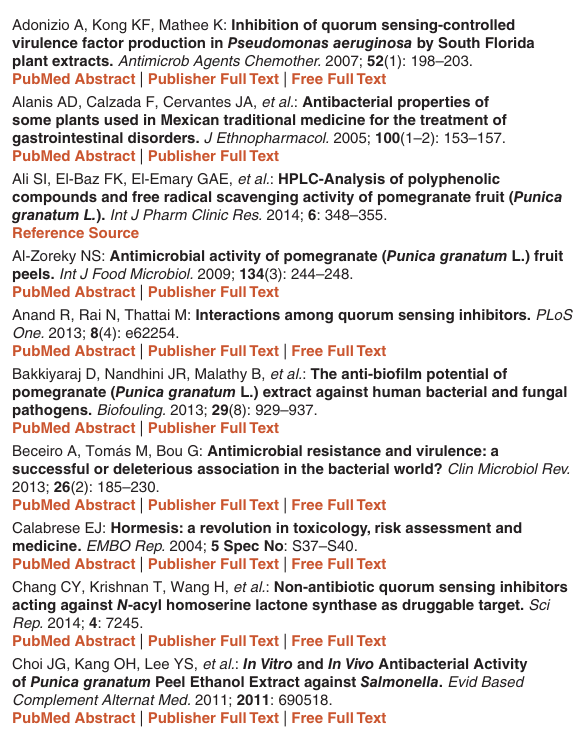
Figure S1. Antipathogenic effect of Pomella on P. aeruginosa . Figure S2. Quorum-inhibitory effect of cinnamic and chlorogenic acid on violacein production in C. violaceum is not reversed following augmentation of the quorum-inhibited culture by AHL Table S1. Binding affinity of different phytocompounds when docked against LuxR homologue of test